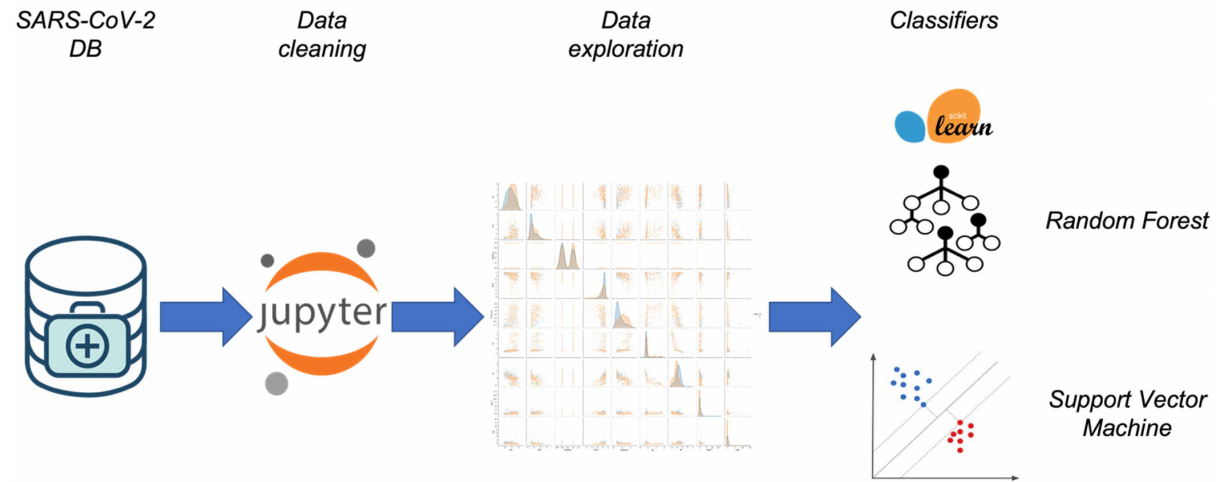
Figure 1. Summary of the machine learning approach: the data analysis